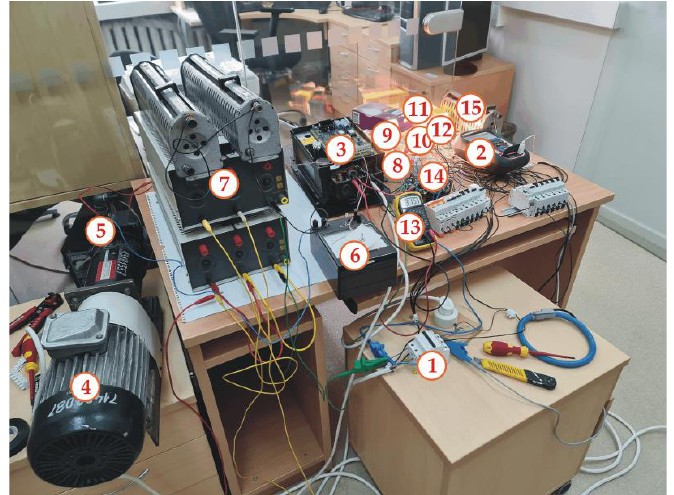
Figure A10. Photo of experimental setup for the reactive power provided or drawn out by diode rectifier supply-side variable frequency drive and LED light devices analysis.